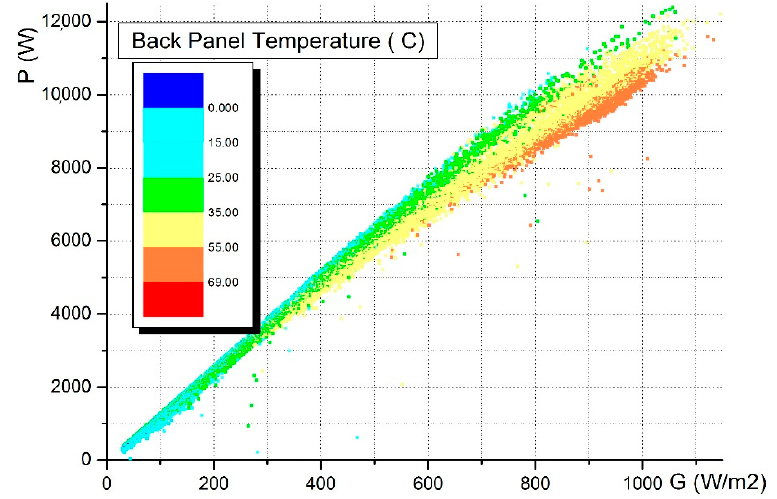
Figure 7. Correlation between AC power output, irradiance, and backsheet temperature.